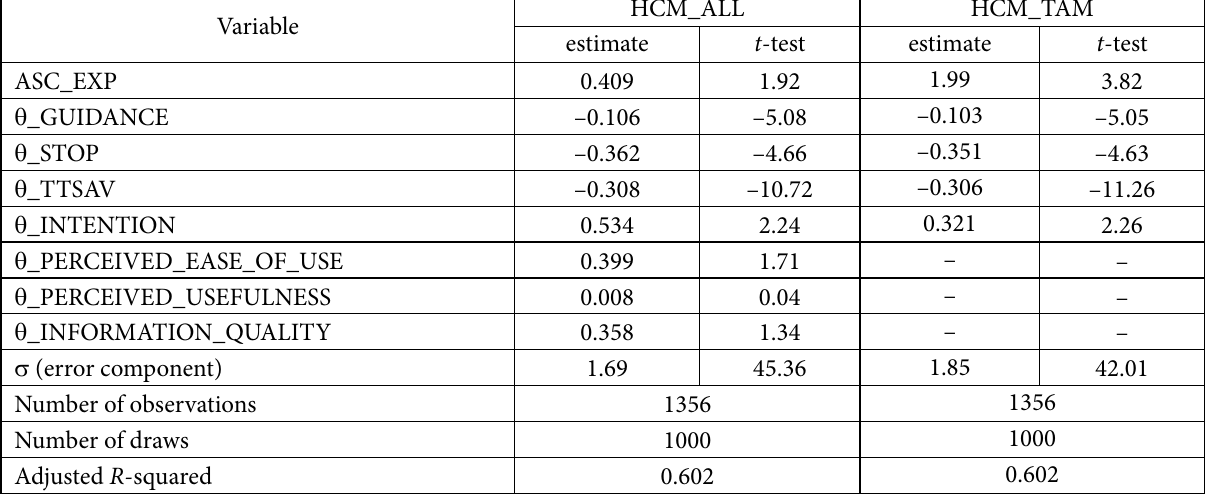
Table 8. Results of the route choice model